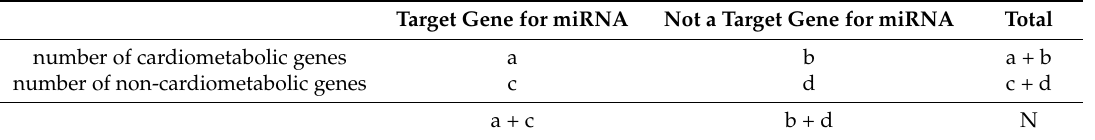
Table 4. A 2 × 2 table for Fisher’s exact